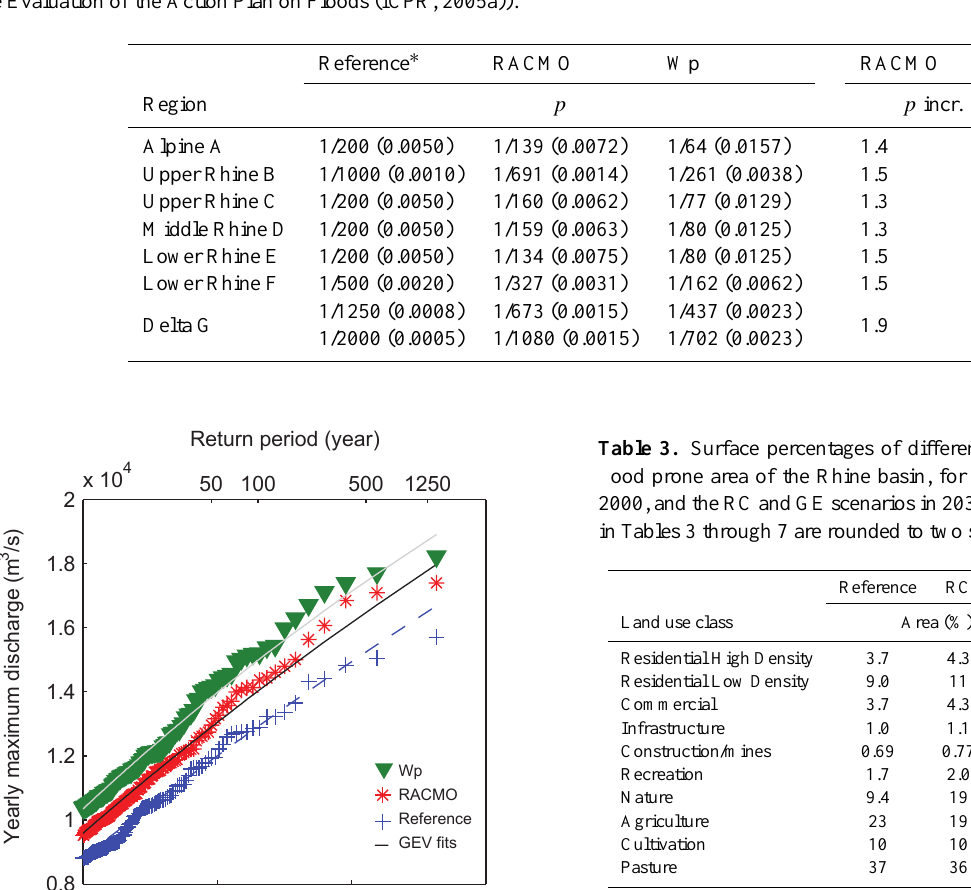
Table 2. Climate change scenarios for increased flooding probabilities in 2030. Flooding probabilities (per year) for the reference situation are estimated based on literature. The probability ( p ) increase is displayed as a factor ( ∗ estimate, based on Silva and Van Velzen (2008) and on the Evaluation of the Action Plan on Floods (ICPR, 2005a)).